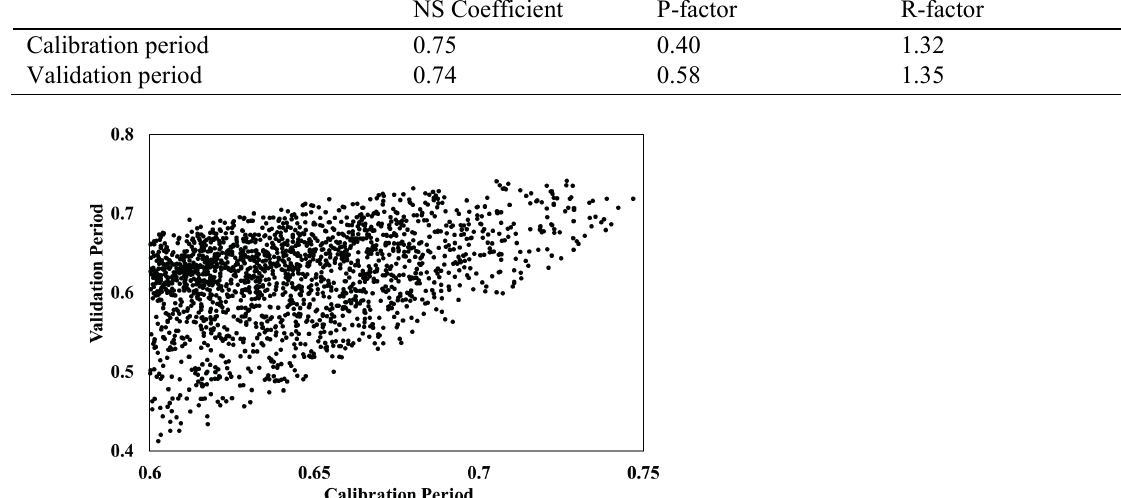
Fig. 5 Scatter plots of the NS coefficient values of the behavioural parameters for the calibration period versus for the validation